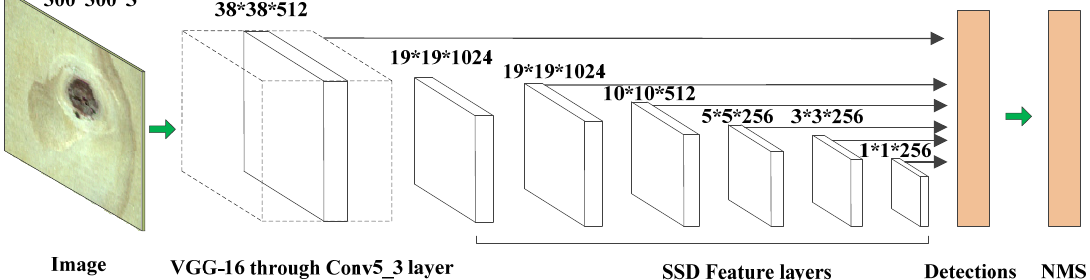
Figure 5. General framework of the SSD algorithm.